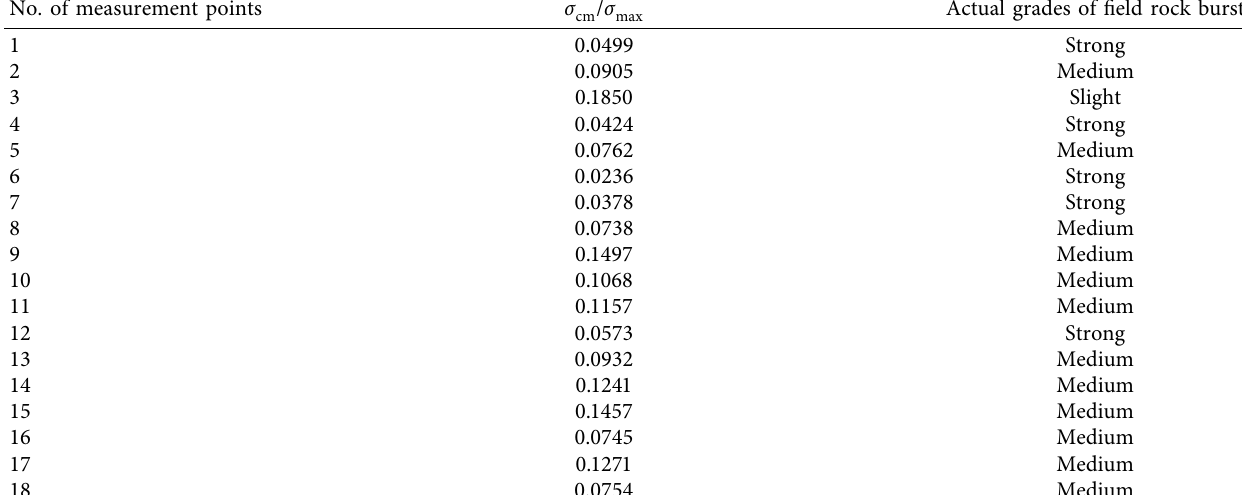
cm to σ c various measurement